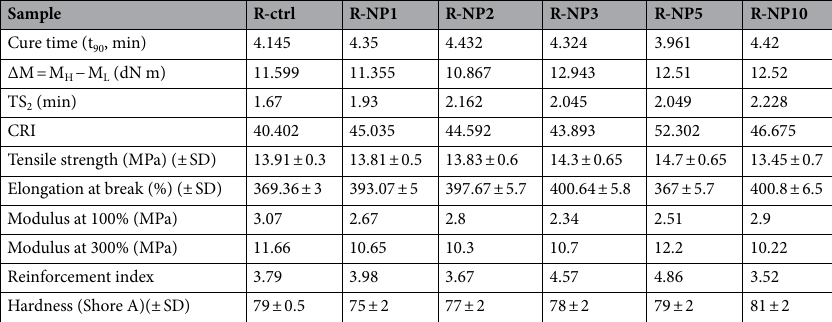
Table 2. The curing and mechanical properties of the pure nano silica-NBR samples.